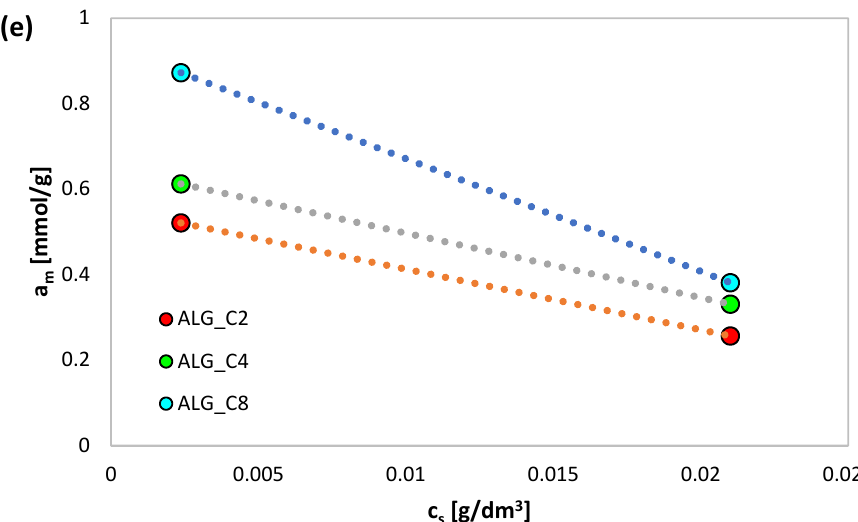
Figure 4. Comparison of the adsorption isotherms ( a , b ) (lines represent the fitted GL equation), the adsorption capacities ( c ) and proposed adsorption mechanism ( d ) for ibuprofen and diclofenac on ALGCa, ALG_C2, ALG_C4, and ALG_C8. The dependence of adsorption capacity on solubility ( e ) of ibuprofen and diclofenac on alginate–carbon materials.